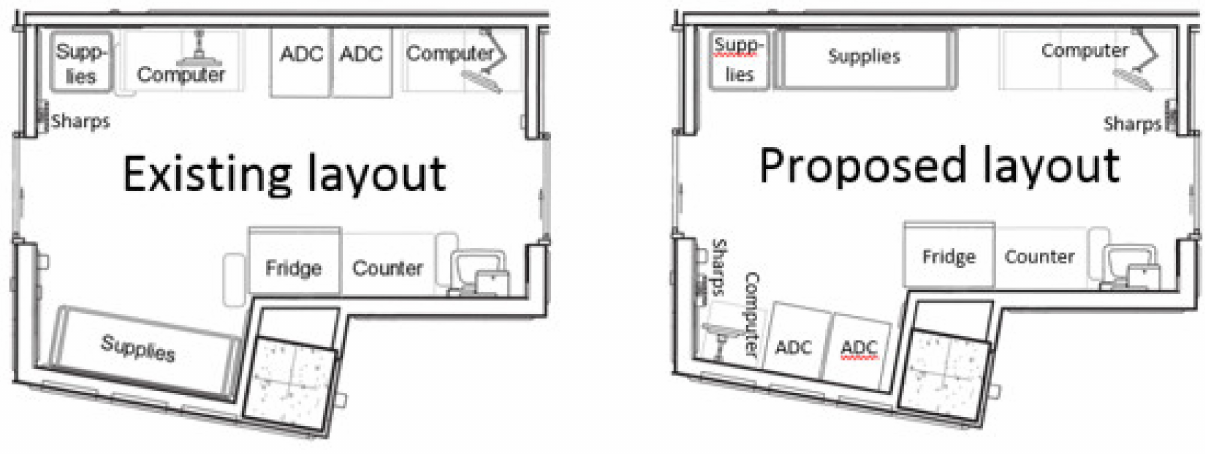
Figure 3. Two medication room layouts were evaluated: the existing ( left ) and the proposed ( right